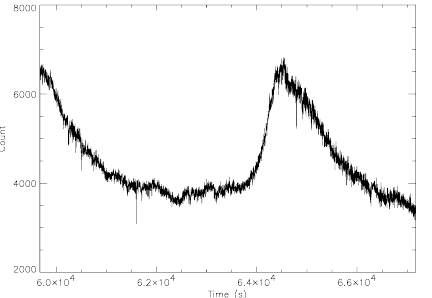
Fig. 2. The TAOS light curve of CY Aqr, estimated by the flux within a 3 × 3 aperture box, with the sky sub- tracted. The abscissa is time in s from UT=0 h September 16, 2003. The orig- inal 0.3 s data have been smoothed 10 times for illustration